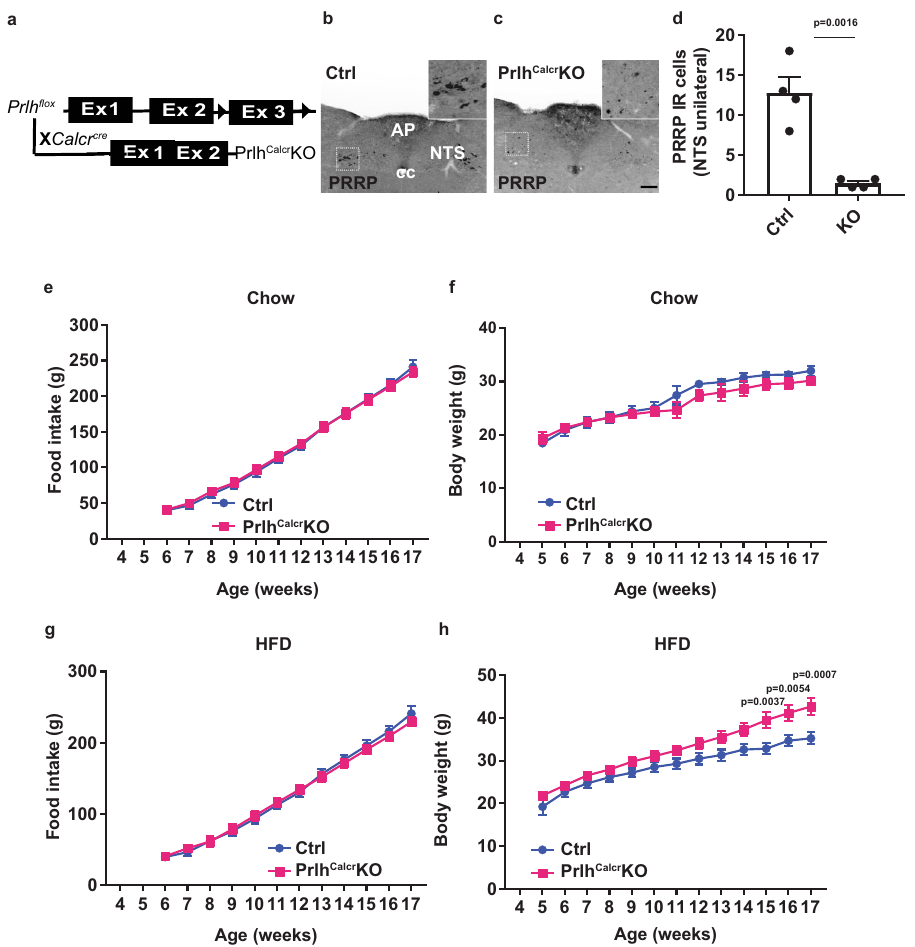
Fig. 3 Deletion of Prlh from Calcr NTS cells exacerbates DIO. A Schematic diagram showing the cross of Prlh Flox onto the Calcr cre background to generate Calcr crecre ; Prlh fl ox/ fl ox (Prlh Calcr KO) mice. B , C Representative images showing PRRP-IR in the NTS of Calcr cre/cre ; Prlh + / + control ( B , Ctrl) and Prlh Calcr KO ( C ) mice. Insets show digital zooms of the boxed regions. All images taken at same magni fi cation; scale bar equals 150 µ m. D Quanti fi cation of PRRP-IR in the NTS of control (Ctrl) and Prlh Calcr KO mice, as in B, C; n = 4 animals/group. E – H Weekly food intake ( E , G ) and body weight ( F , H ) for Ctrl and Prlh Calcr KO fed with chow ( E , n = 7 animals/group; F , n = 6 Ctrl animals and n = 10 Prlh Calcr KO animals) or HFD ( G , H ) from the time of weaning at 4 weeks of age. Shown is mean + / − SEM. Two-way ANOVA, sidak ’ s multiple comparisons test was used: p values are shown for signi fi cant comparisons. All experiments were repeated in two independent cohorts of animals with similar results; were generally combined for